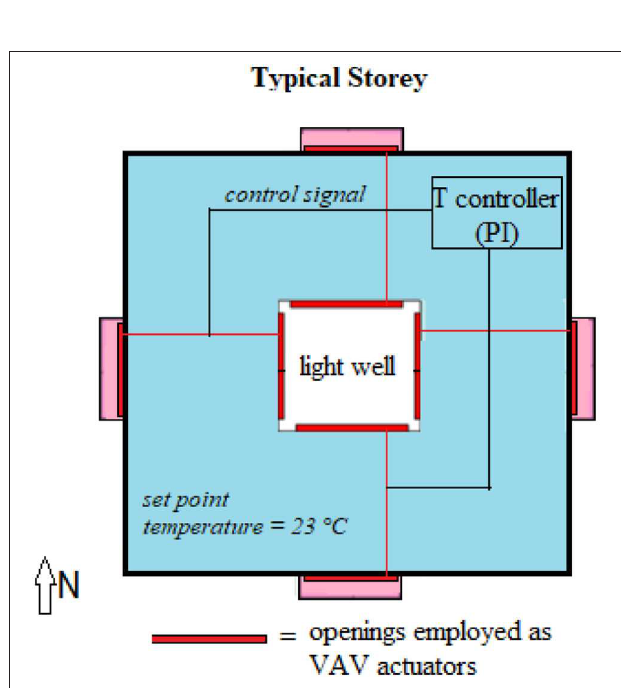
FIGURE 4 | Hybrid 1: Typical story using the light well as a cooling source and the stacks as vents.